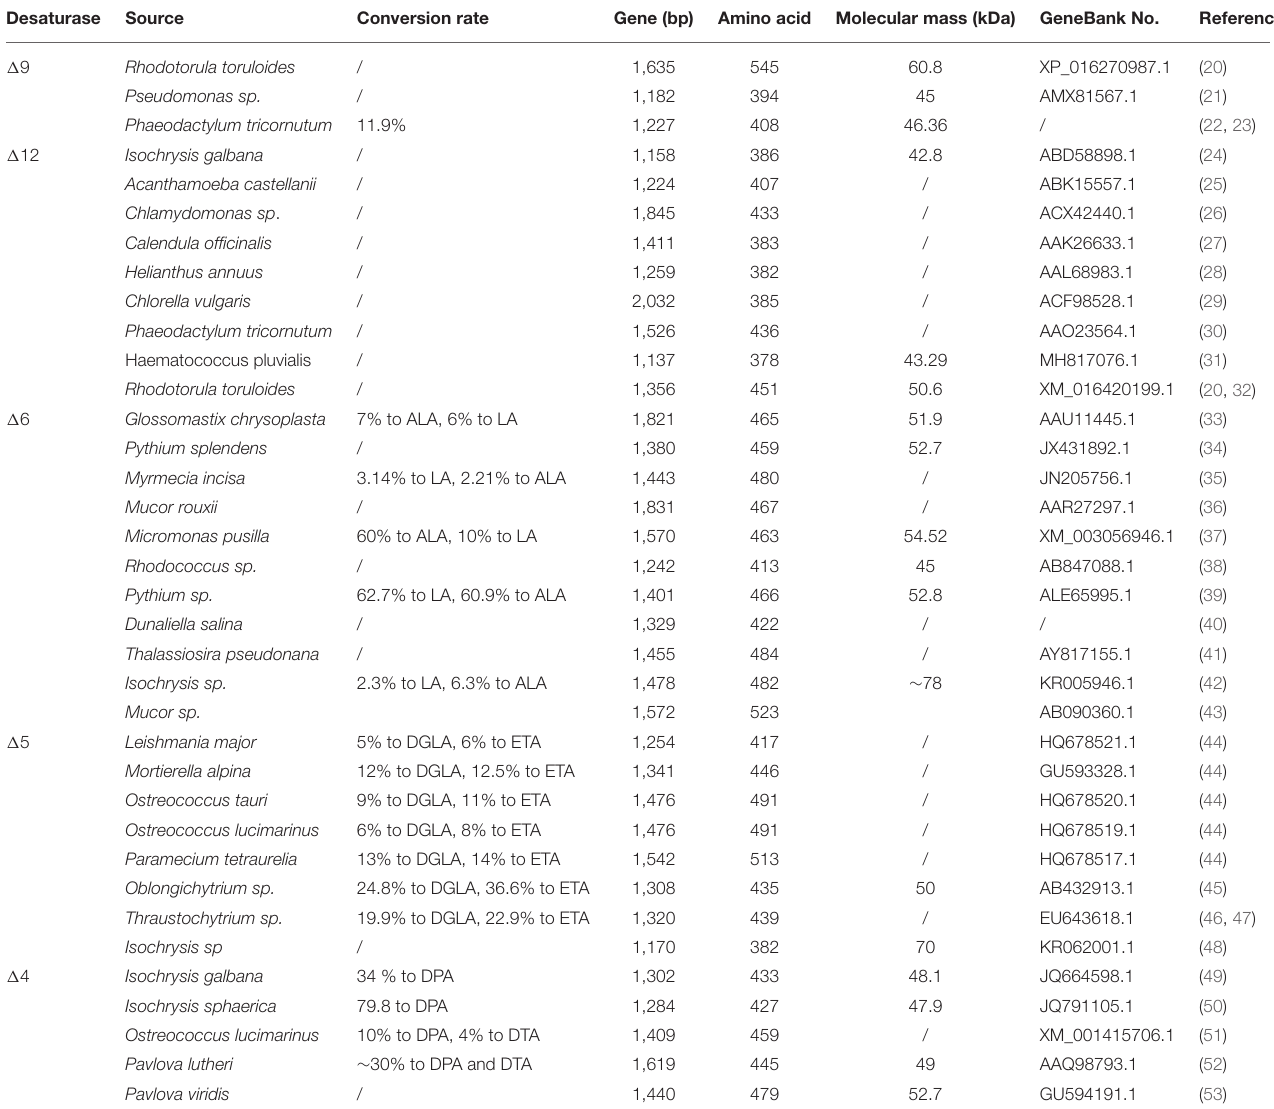
TABLE 1 | The characteristic of the desaturase in ω -6 and ω -3 pathway. Desaturase